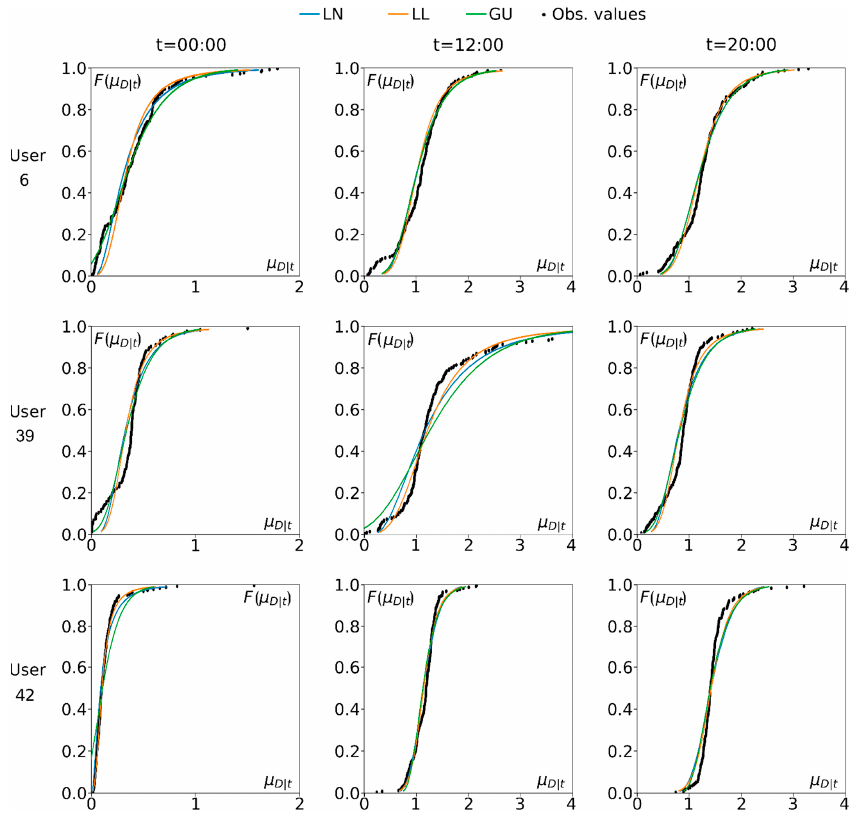
Figure 6. Comparison between the three cumulative distribution functions Log-Normal (LN), Log-Logistic (LL), and Gumbel (GU), and the observed cumulated frequencies of the daily heat load pattern 𝑤 𝑑 (-) of three users at different times of the day.